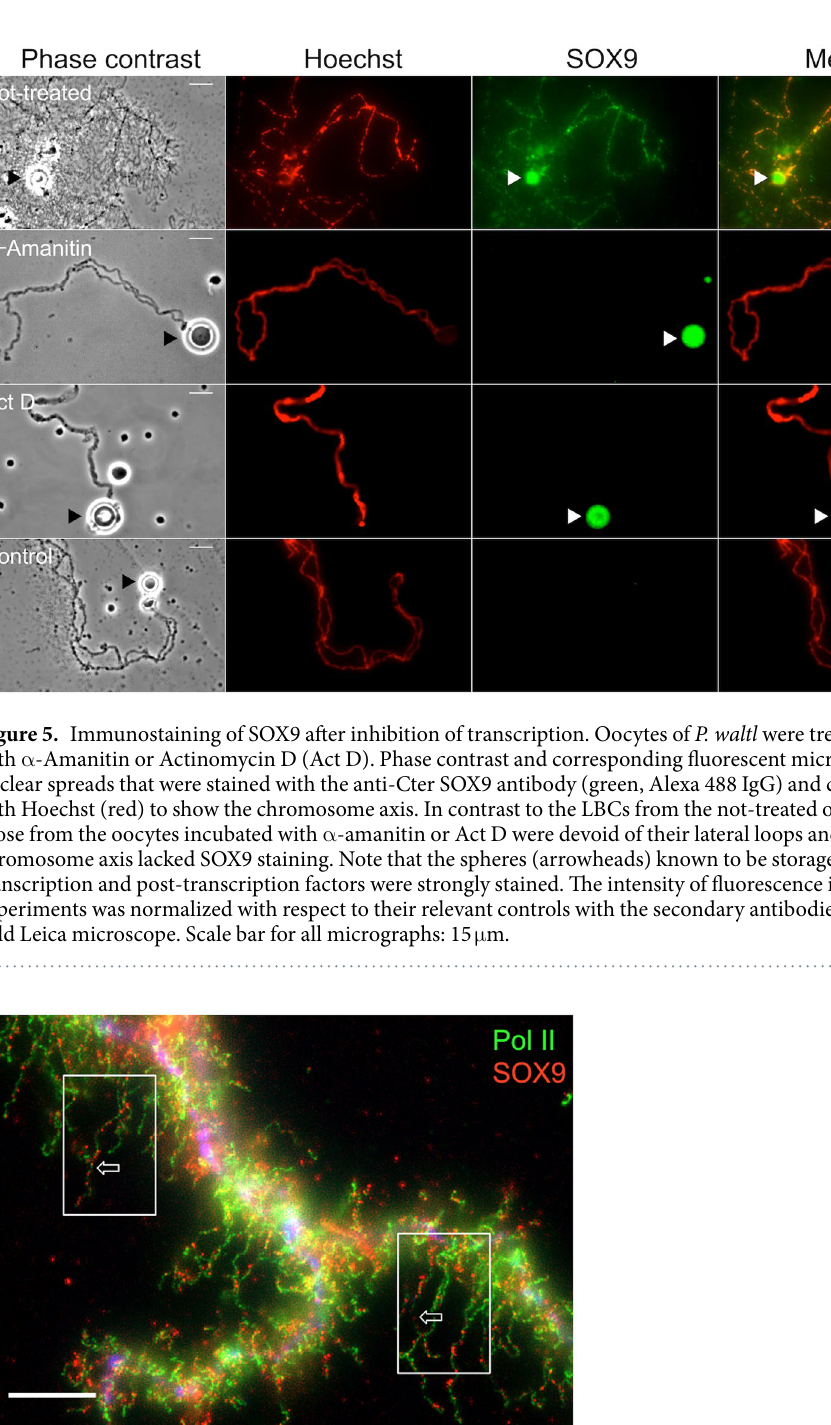
decondensed DNA axis of lateral loops undergoing transcription but rather with the resulting RNP transcripts. The fact that the association of SOX9 with the RNP matrix is RNA-dependent supports this conclusion. The super resolution microscopy data clearly show that SOX9 exhibits the same granular fluorescence pattern as CELF1